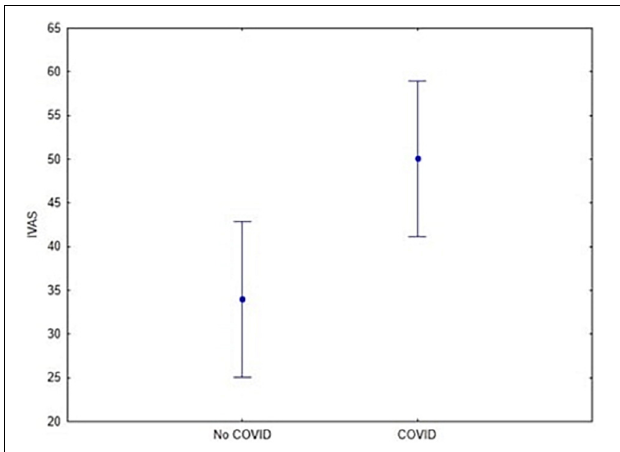
FIGURE 4 | Interaction between Diagnosis and Gender ( F = 4.63; p = 0.03) through IES-R scores. Vertical bars denote 0.95 confidence intervals.